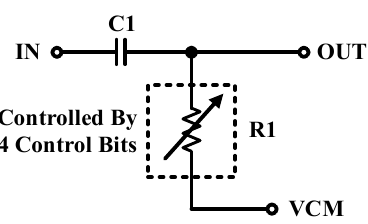
Figure 5. The schematic of the DCOC block of the system.